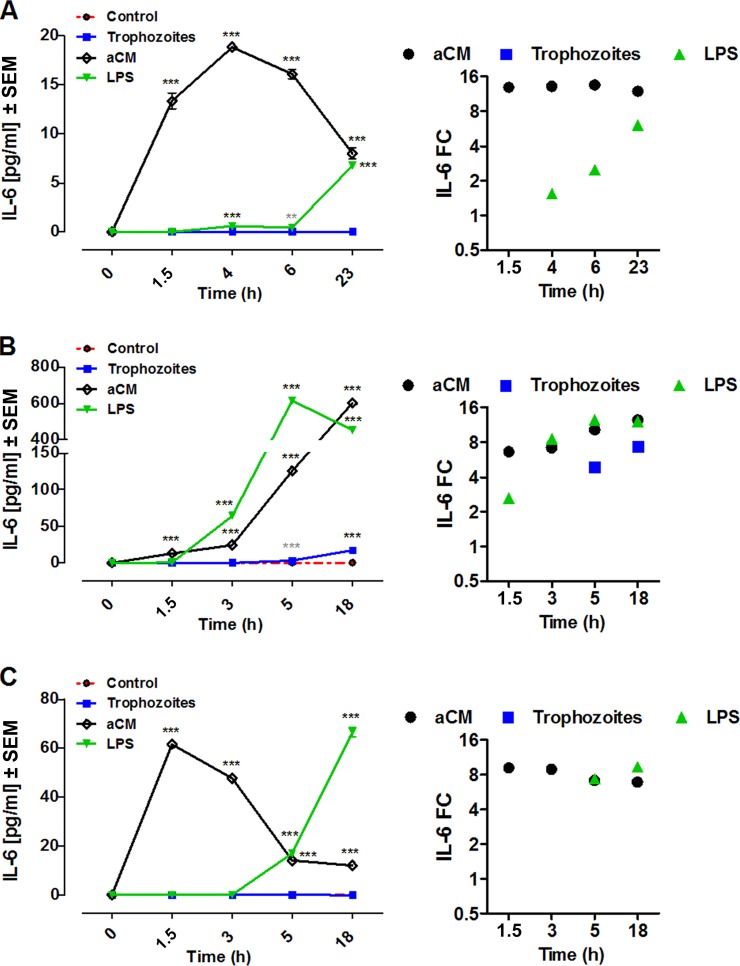
IL-6 production by THP-1 (A), PBMCs (B), and MDMs (C) after coincubation with trophozoites of A. castellanii (trophozoites) or stimulation with aCM. A total of 2 × 105 of either target cells were challenged with either 2 × 104 trophozoites, ratio of 10:1, or with 800 μl of aCM (final dilution of 4:5 in the culture medium). IL-6 concentration in THP-1 experimental supernatants was evaluated at 1.5, 4, 6, and 23 h poststimulation, whereas in both PBMC and MDM experimental supernatants it was evaluated at 1.5, 3, 5, and 18 h poststimulation. All three cellular models were stimulated with 10 ng/ml LPS as a positive control, whereas unstimulated cells (control) were considered the negative control. Experiments were performed in triplicate and repeated at least 3 times. Results represent the mean values ± SEM of either n = 5 (THP-1) or n = 3 (PBMCs and MDMs) samples. One-way ANOVA was applied for each time point. Dunnett's multiple-comparison test was performed to evaluate differences between the experimental condition means and the control at each time point. In the graphs, significances between the experimental conditions and the control are indicated as a P value of <0.0001 (***). Student t test was also applied at each time point to verify the significance of single pairs of means (single experimental condition versus control). In the graphs, significance between the experimental condition and the control, obtained with Student t test, are indicated as P values of <0.005 (**) and <0.0001 (***). On the right, the same results are expressed as fold change (FC) over the unstimulated cells.